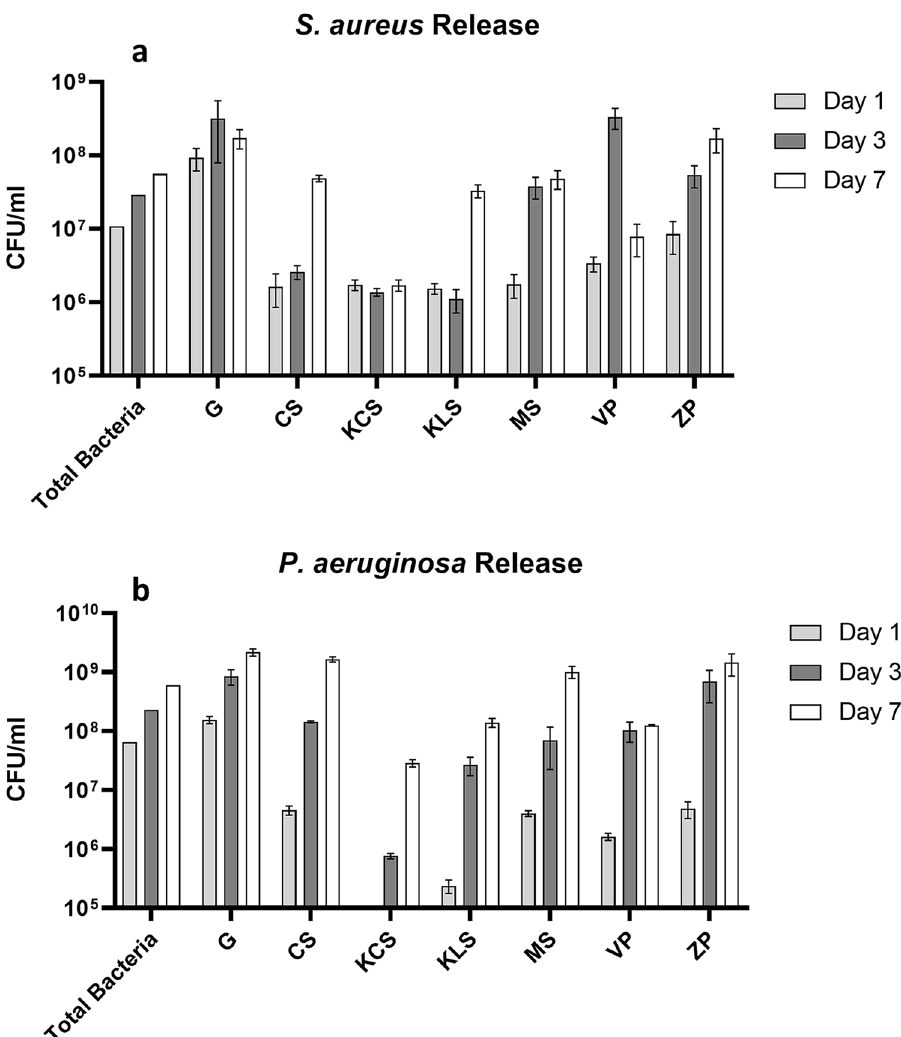
Figure 4. Variable bacterial release of superabsorbent dressings. Superabsorbent wound dressings were inoculated daily with 1 * 10 7 CFU/ml of either Staphylococcus aureus or Pseudomonas. aeruginosa daily, over 7 days in triplicate. On 1, 3 and 7 days of inoculation, dressings were lysed, any antimicrobial activity neutralised and bacterial load was quantified via serial dilutions. Colony-forming units (CFU/ml) determined via colony counts are shown for S. aureus ( a ) and P. aeruginosa ( b ). The following dressings were tested: Gauze (G), ConvaMax Superabsorber (CS), 3M Kerramax Care Super-Absorbent Dressing (KCS), Kliniderm Superabsorbent (KLS), Mextra Superabsorbent (MS), Vliwasorb Pro (VP) and Zetuvit Plus (ZP). Data are shown as mean (+/− SEM, n = 3). Figure produced in GraphPad Prism